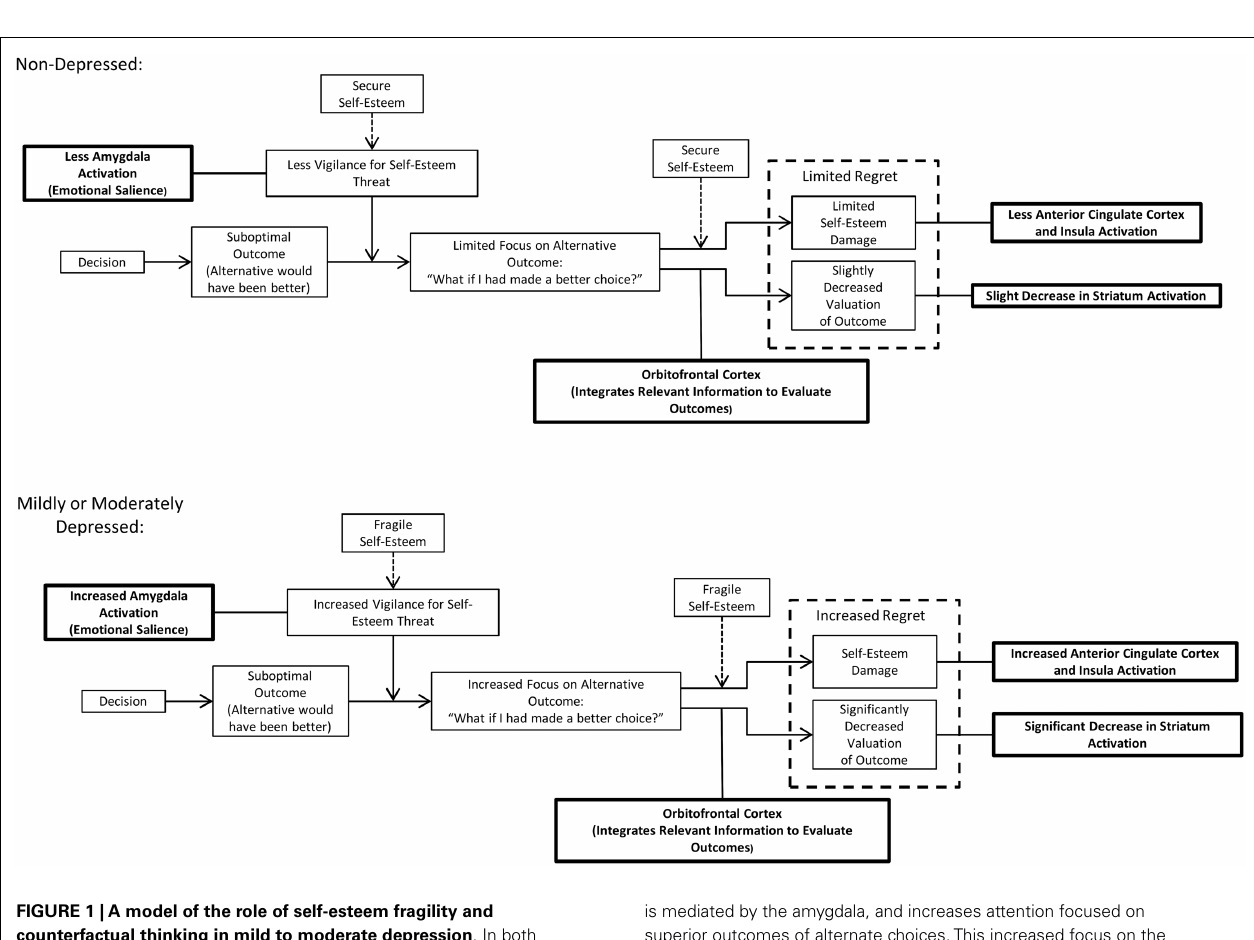
FIGURE 1 |A model of the role of self-esteem fragility and counterfactual thinking in mild to moderate depression . In both non-depressed and mildly to moderately depressed individuals, learning that a different choice would have had a better outcome will result in self-related counterfactual thoughts, i.e., “what if I had chosen differently.”These thoughts will lead to feelings of regret, an aversive emotion. However, individuals with mild to moderate depression are more prone to regret because they have fragile self-esteem. In the model, fragile self-esteem will affect regret in two ways: (1) fragile self-esteem will result in greater vigilance for threats to self-esteem, including suboptimal decision outcomes.This vigilance